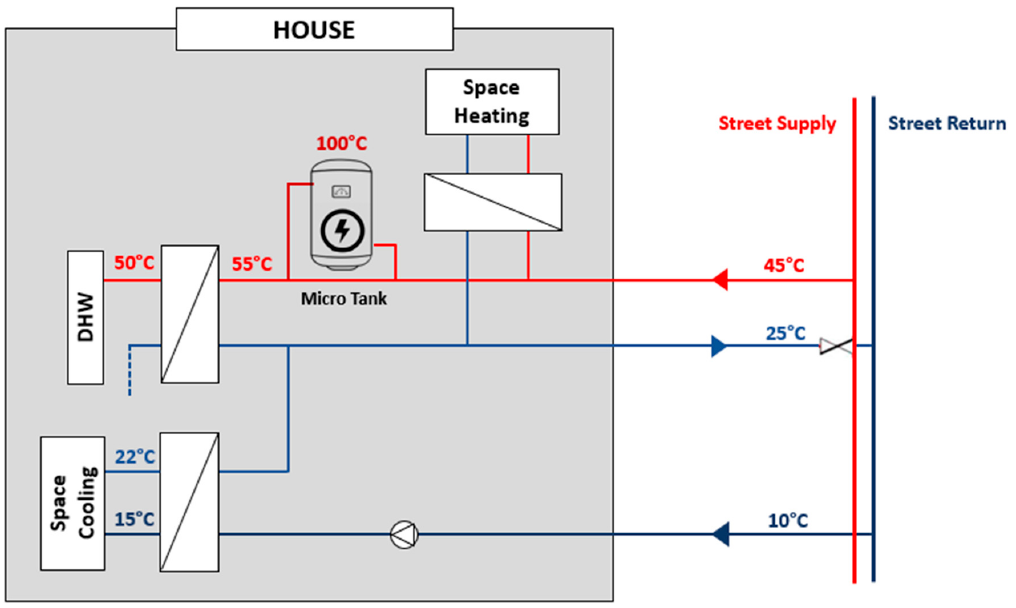
Figure 3. End-users’ substation schematics.